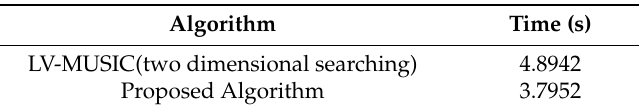
Table 2. The running time of two